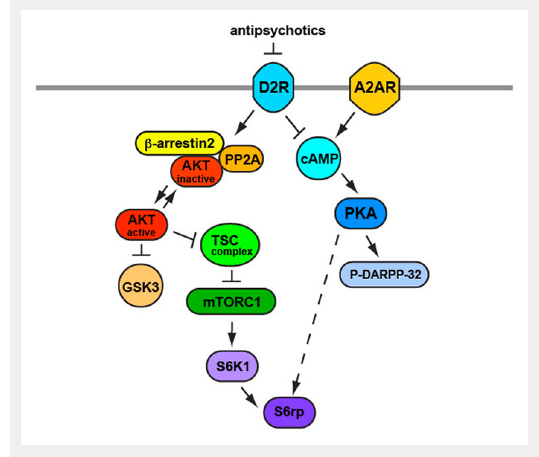
Schematic representing the action of antipsychotics on intracellular signaling cascade. Inhibition of D2Rs by antipsychotic results in increased cAMP levels produced by removing the tonic inhibition on adenylyl cyclase activity (see text for more details). This leads to activation of PKA and phosphorylation of DARPP-32. Moreover, antipsychotics, by antagonizing D2Rs, inhibit the activation of β-arrestin2/PP2A complex resulting in increased AKT activity. Both AKT and PKA lead to activation of mTORC1 and S6 ribosomal proteins, which regulated protein synthesis. AKT ≡ protein kinase B; cAMP = cyclic AMP; D2R = dopamine 2 receptor; DARPP-32 = dopamine- and cAMP-regulated phosphoprotein of molecular weight 32000; mTORC1 = mechanistic target of rapamycin complex 1; PKA = protein kinase A; PP2A = phosphatase 2A; S6K1 = p70 ribosomal S6 kinase 1; S6rp = S6 ribosomal protein; TSC = tuberous sclerosis